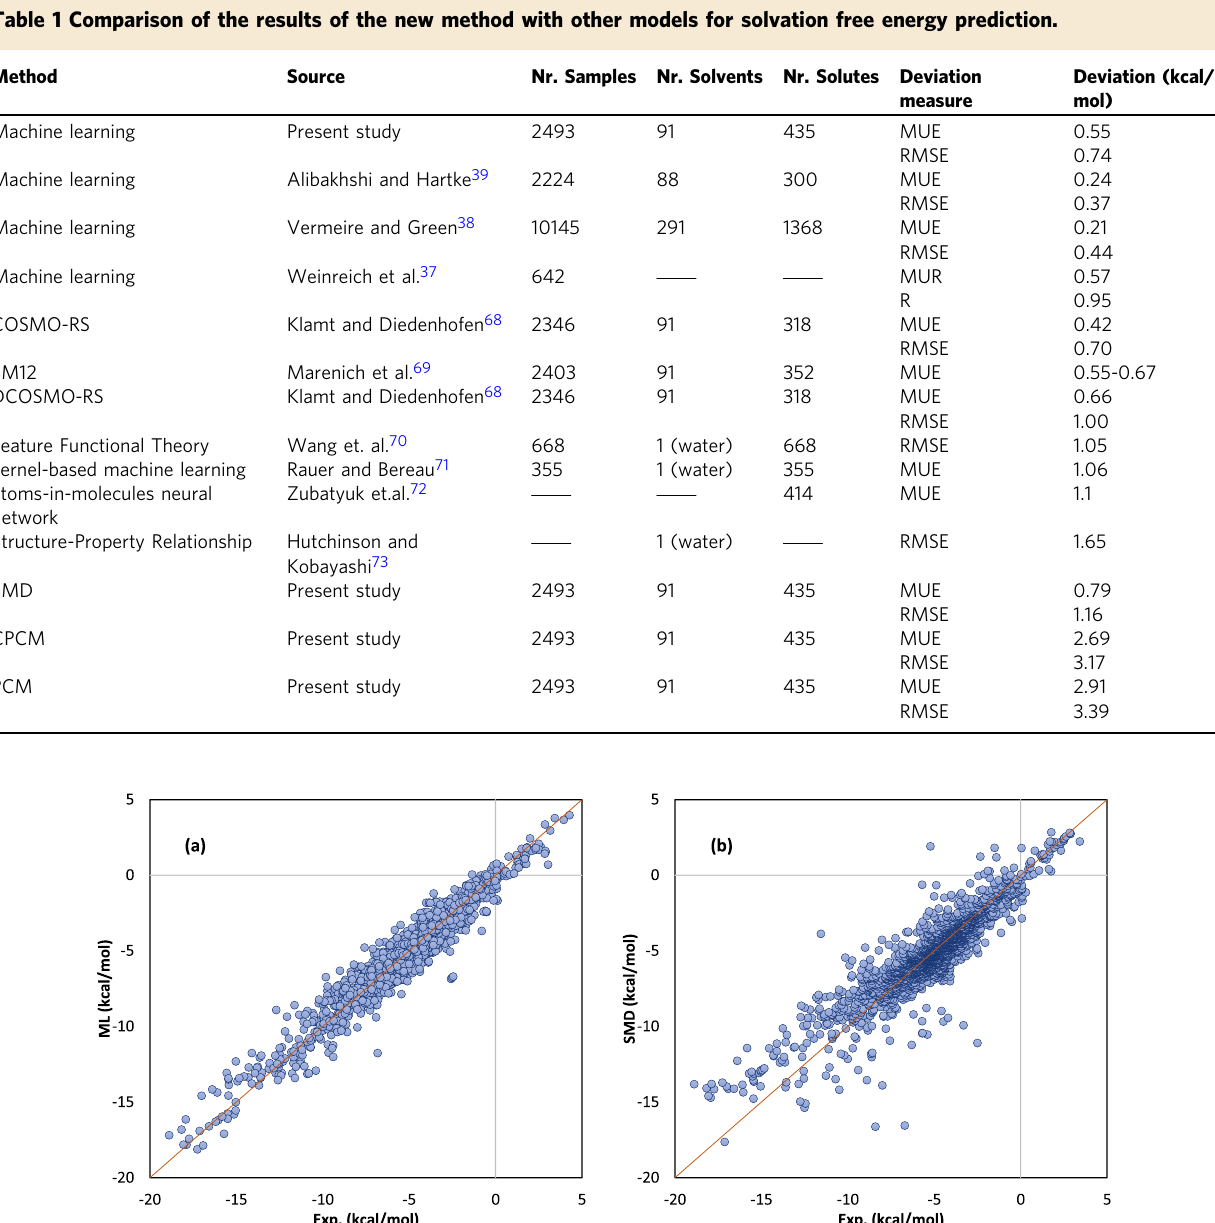
Fig. 4 Comparison of predicted and reference solvation free energies. The solvation free energies predicted via ML ( a ) are in better agreement with the reference data in comparison to the SMD method ( b